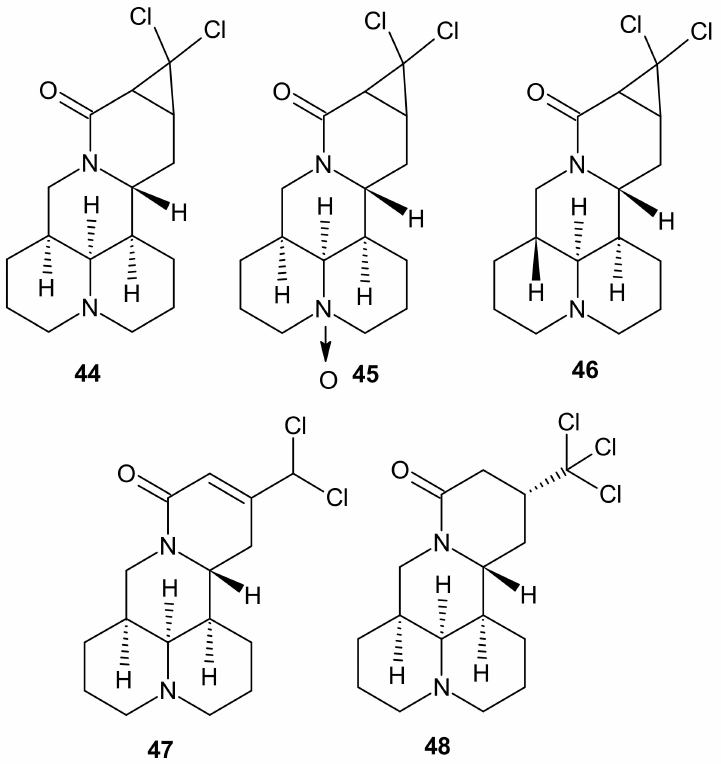
Figure 14. Alopecines A-E 44 – 48 .